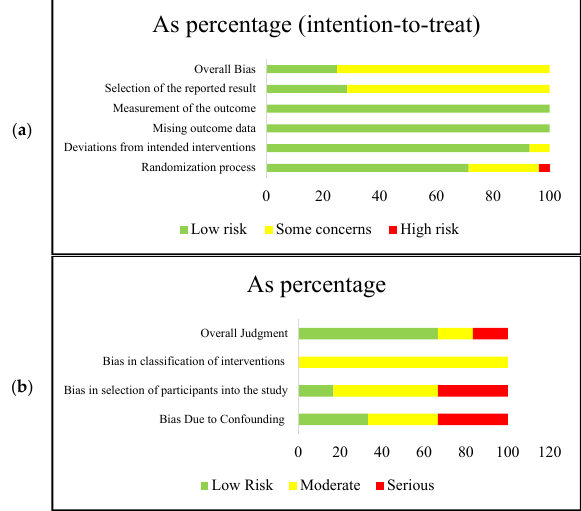
Figure 1. Risk of bias for randomized controlled trials ( n = 27) ( a ) and non-randomized controlled trials ( b ). Based on the revised Cochrane Risk-of-Bias tools for randomized controlled trials (ROB-2) and non-randomized controlled trials (ROBINS-1) ( n = 6).